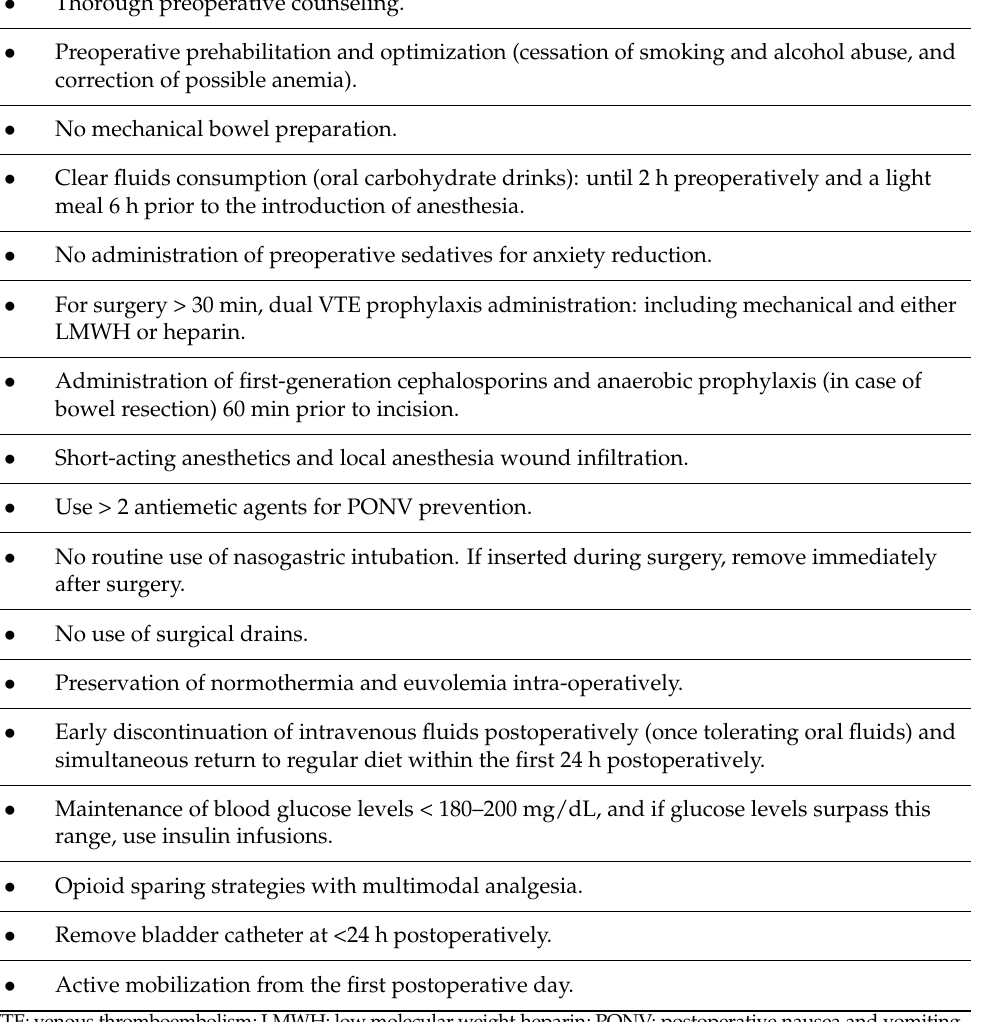
Table 2. Key principles of ERAS protocols in